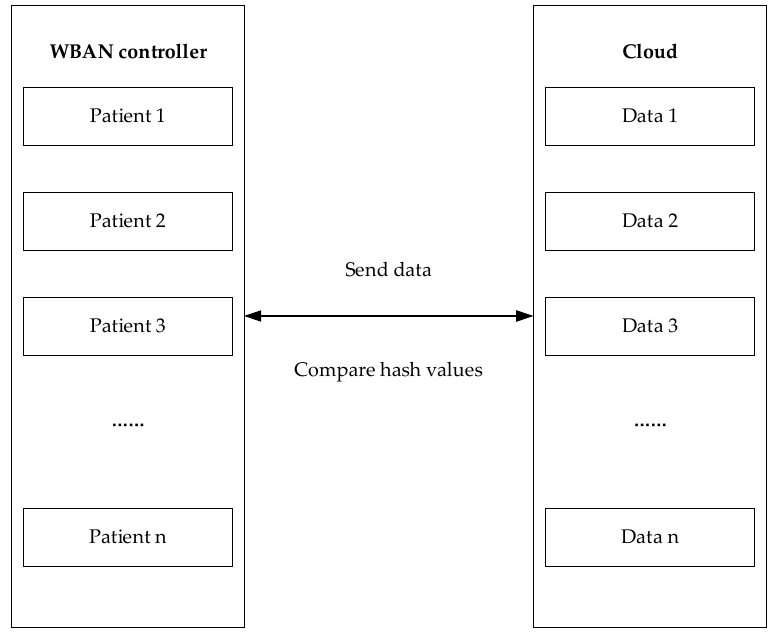
Figure 4. Data verification chart .